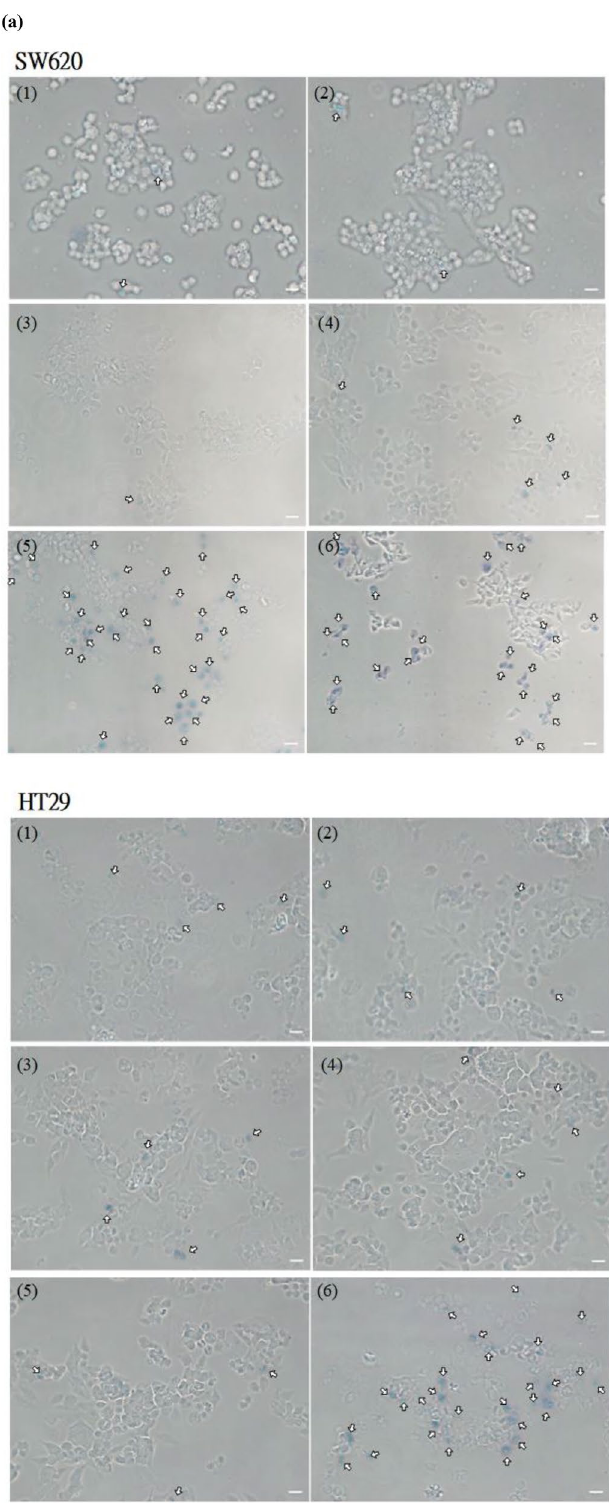
Figure 3. In vitro toxicity of HlyE. ( a ) Examination of cell viability by trypan blue exclusion assay. After the treatment for 30 min, cell suspension was mixed with an equal amount of 0.4% trypan blue dye. The mixture was incubated 2 min at room temperature. 1, Mock; 2, LB medium; 3, extracellular HlyE from induced EcNe/HlyE; 4, intracellular HlyE from induced EcNe/HlyE. ( b ) Examination of cell viability by MTT assay. Tumor cells were treated with HlyE from induced EcNe/HlyE for 3 h. SW620 or HT29 cells were administrated with the various levels of HlyE as indicated. ( c ) Time-lapse images of cell morphology. Images of SW620 (upper) and HT29 cells (bottom) were taken over time as indicated on the left upon the HlyE treatment. The administration dose of HlyE was shown on the top of each panel. Arrows indicate internal rearrangement of organelles and loss of membrane integrity. Cell images were processed with GEN5 3.0 software